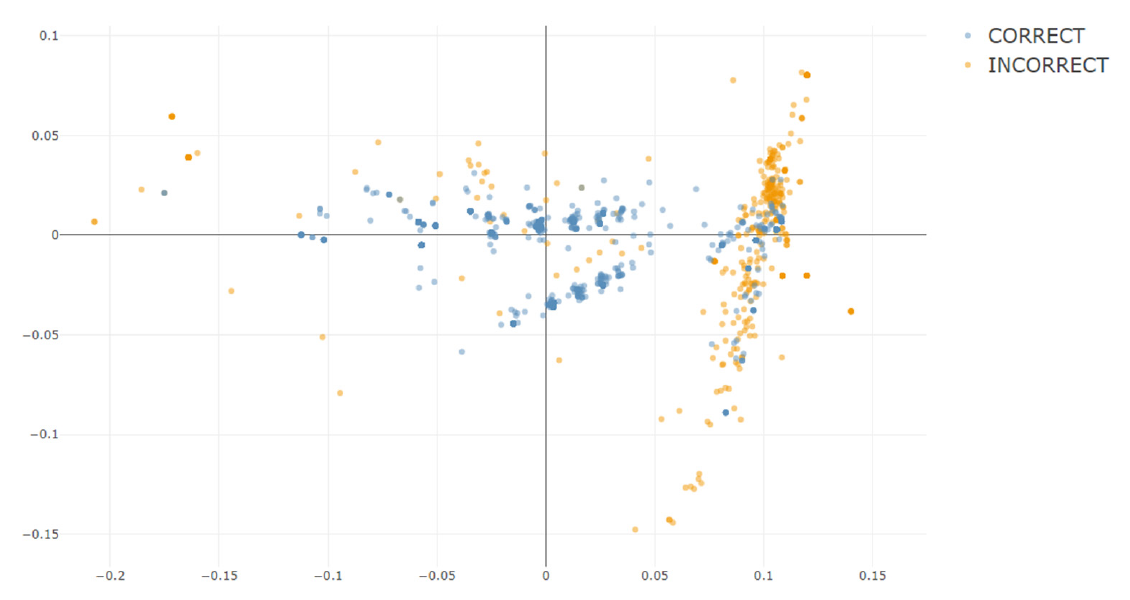
Figure 8. Response semantics of the demo data set in shinyReCoR. The colors distinguish the human raters’ codings as correct (blue) and incorrect (orange). Here, the semantic space is reduced to two dimensions using principal component analysis.